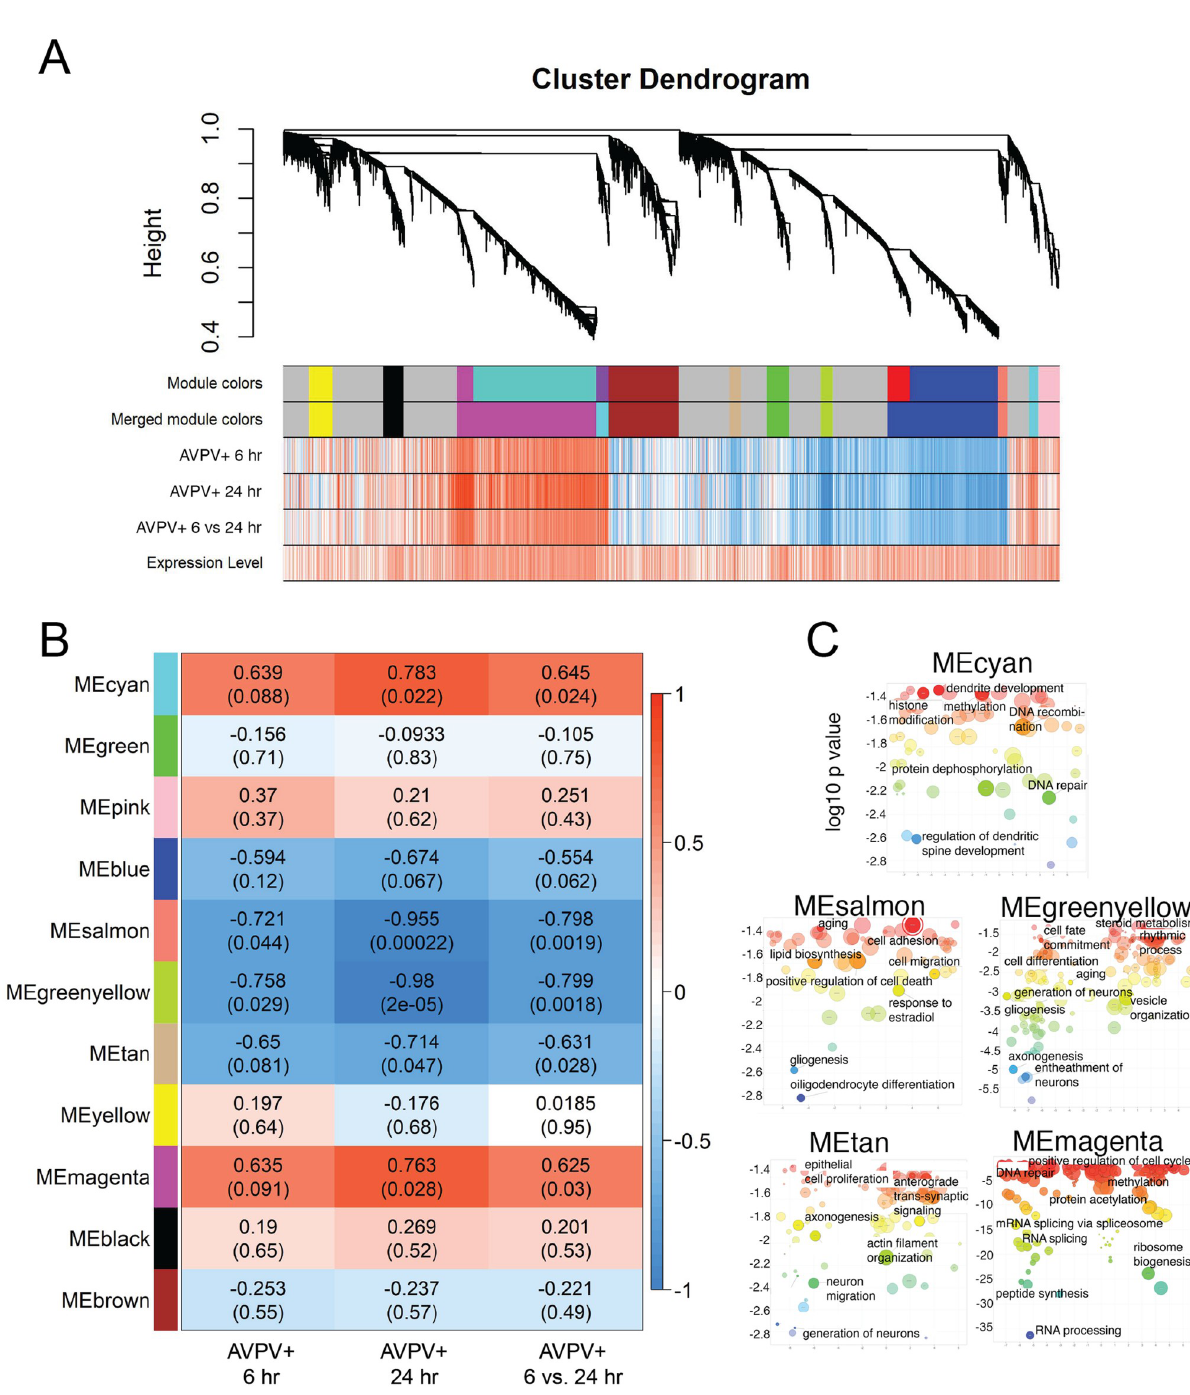
PLOS ONE | https://doi.org/10.1371/journal.pone.0256148 August 18,